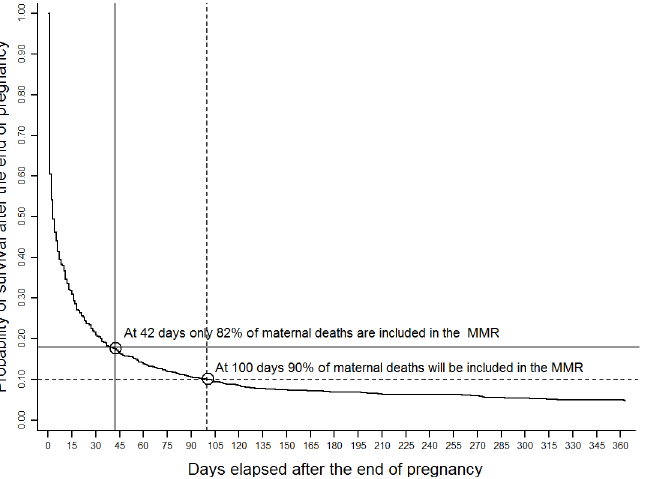
Fig 2. Probability of survival by days elapsed after the end of pregnancy; Kaplan-Meier survival function. Mexico, 2013.